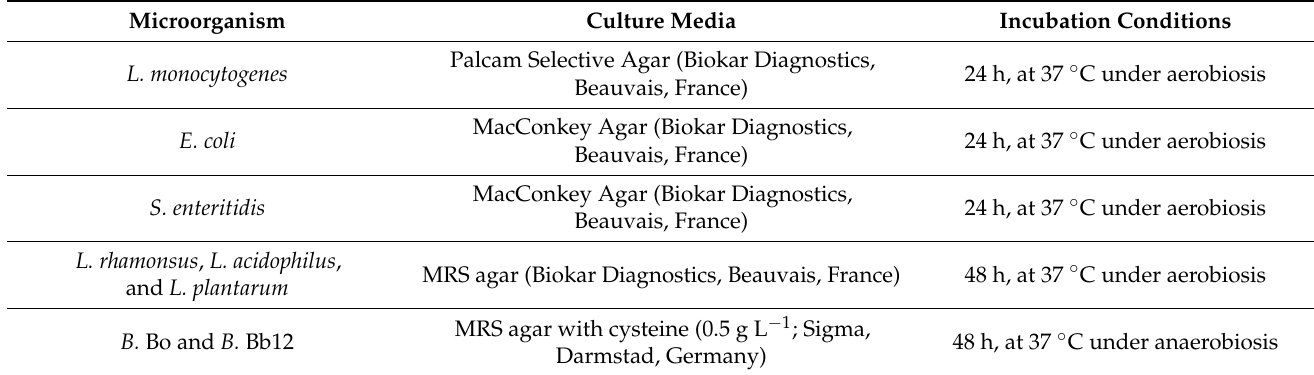
Table 2. Culture conditions for each